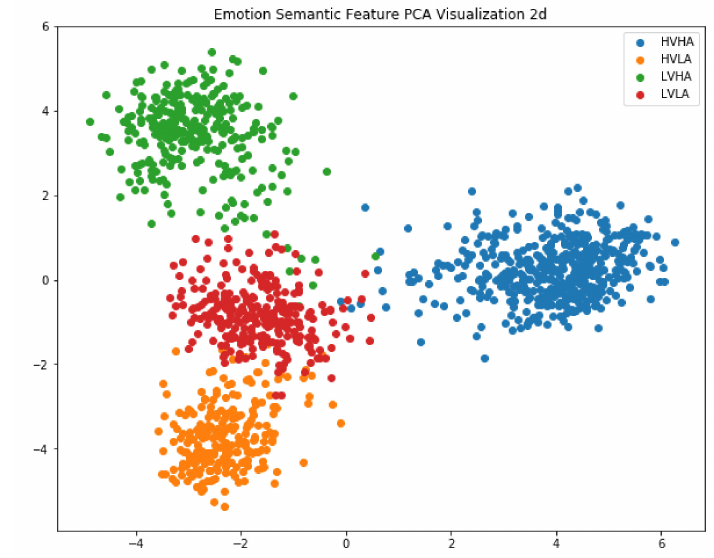
Figure 7. Visualization of LSTM features. The features were dimension-reduced by principal component analysis